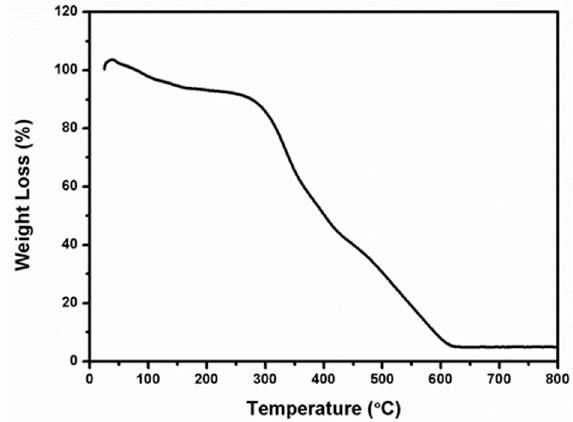
Figure 3. Thermogravimetric-derivative thermal analysis of as-spun Al 2 O 3 precursor microfibers ◦ C / recorded in air at a heating rate of 10 °C/min. recorded in air at a heating rate of 10